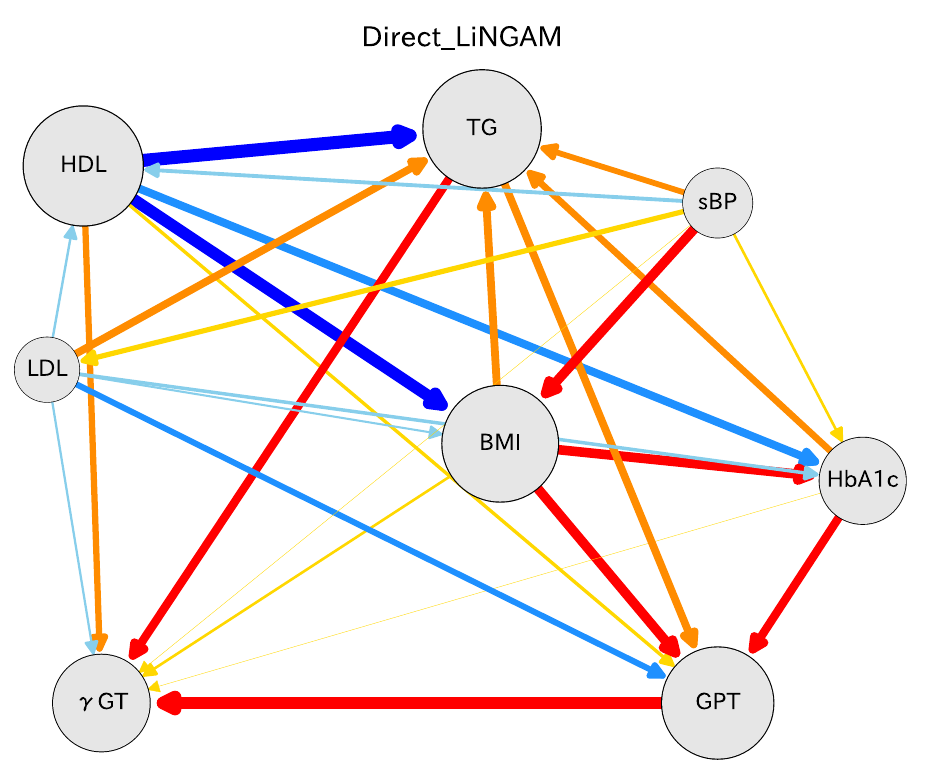
Fig 7. Causal diagram for women in their 70s. This figure uses 8 indices instead of the 11 indices shown in Fig 3. The causal relations and the correlation coefficients are much more robust than in the case of 11 indices. The colors and the arrow thicknesses are used for causal relations, as depicted in Fig